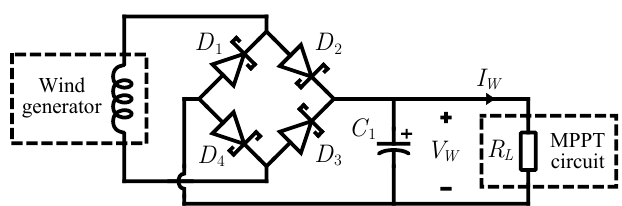
Figure 3. Circuit diagram of the full-wave rectifier used to convert the voltage generated by the wind generator from AC to